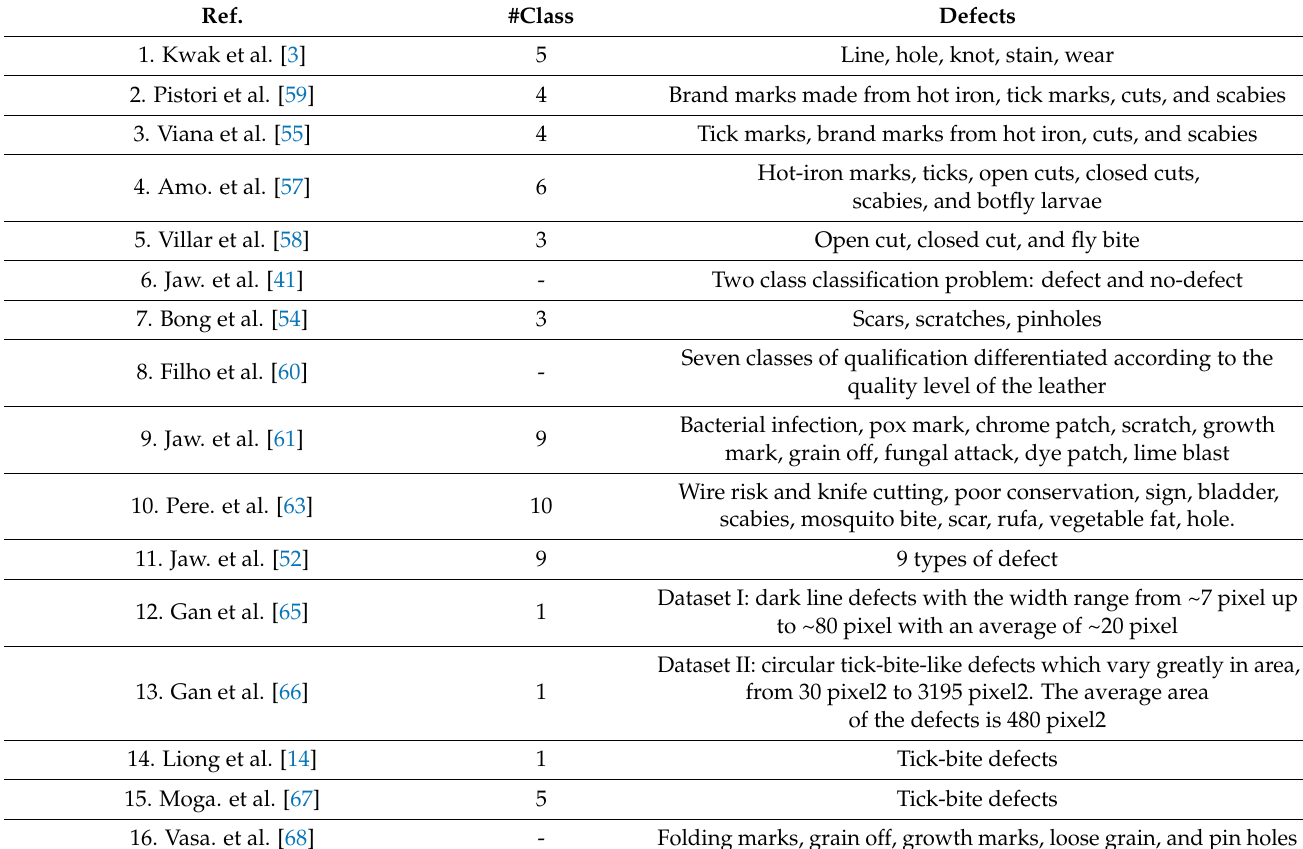
- Folding marks, grain off, growth marks, loose grain, and pin